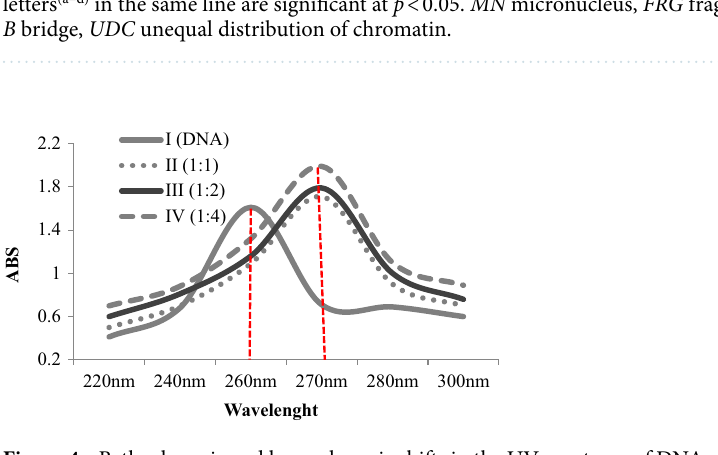
Figure 4. Bathochromic and hyperchromic shifts in the UV spectrum of DNA after interaction with